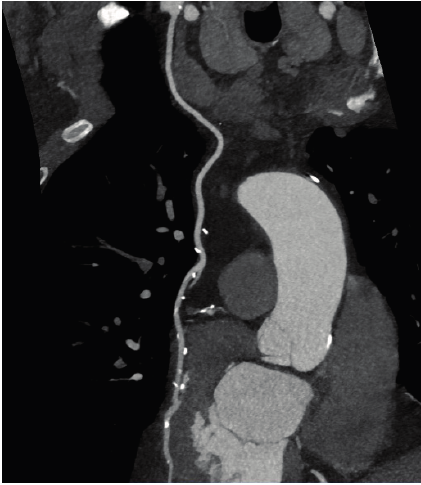
Figure 3. LAD after revascularization with a patent drug eluting stent showing a very good result 18 months after implantation.